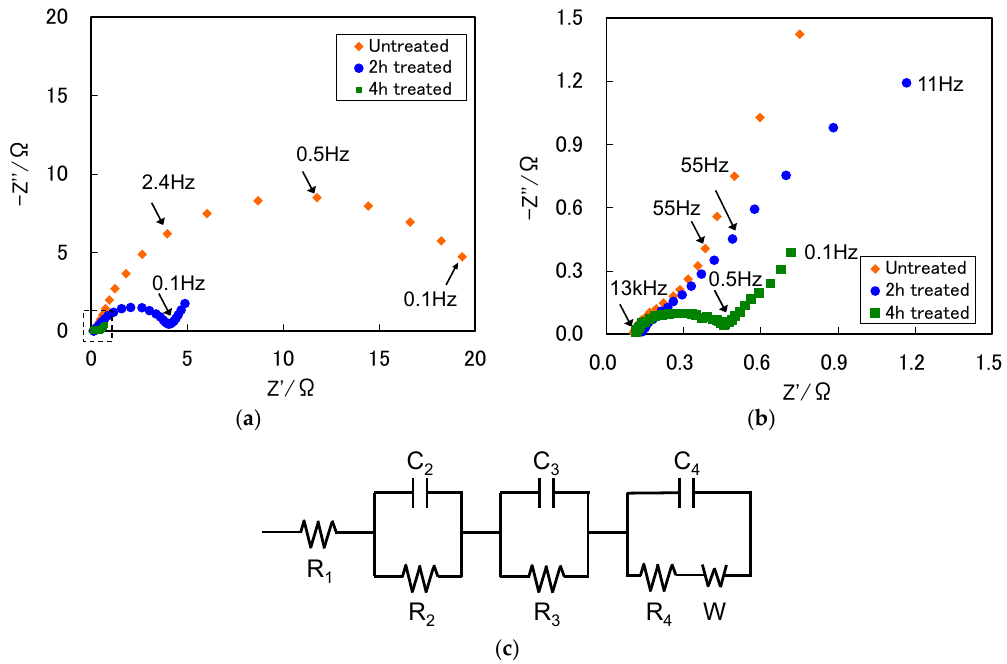
Table 1. Resistances ( R 1 –R 4 ) and capacitances ( C 2 –C 4 ) for the ZrNi negative electrode with and without the alkaline treatment for 2 h and 4 h.